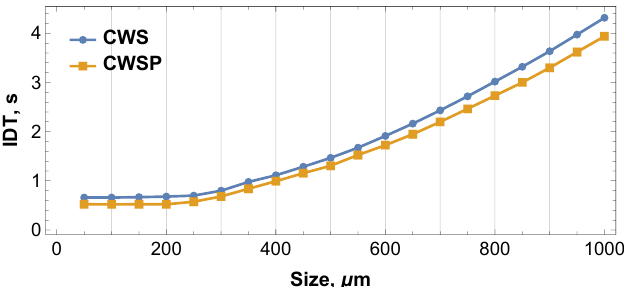
Figure 5. Calculated dependence of the ignition delay time on the particle size for CWS and CWSP when the furnace temperature is about 873